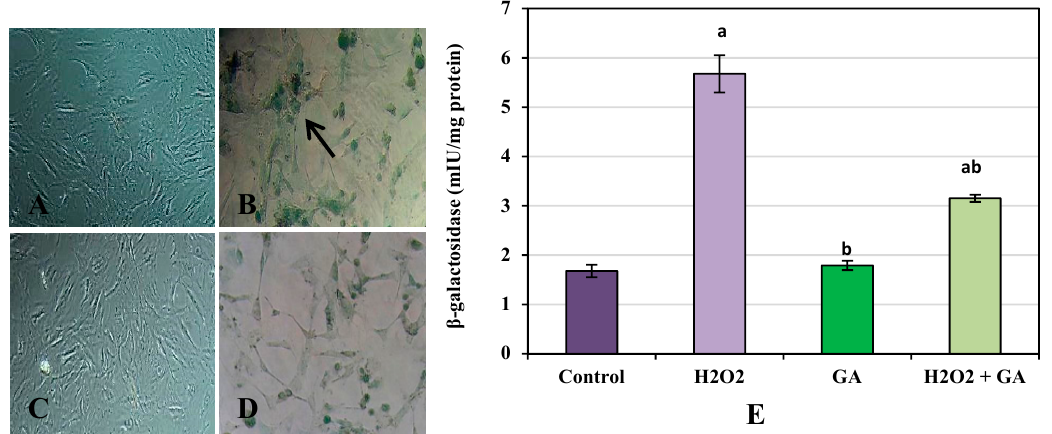
Figure 2. β -galactosidase assay in rat embryonic fibroblast cells (200× magnification). Control ( A ), H 2 O 2 ( B ), Gallic acid ( C ), H 2 O 2 + Gallic acid ( D ). Quantitative data of β -galactosidase assay are shown in graph ( E ). Data are presented as the mean ± standard error of measurements performed on six groups, with three independent replicates. a Significant difference from control ( p < 0.001), b significant difference from H 2 O 2 ( p < 0.001). Arrow indicates senescent cells.